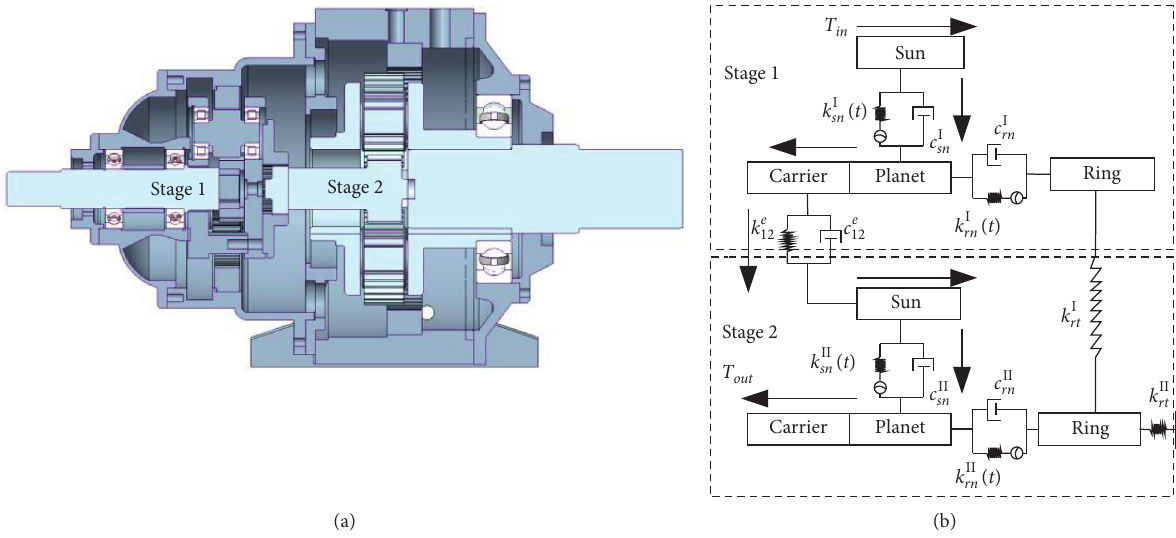
Figure 1: (a) The sectional drawing of the 2-stage planetary gearbox. (b) Schematic diagram of the 2-stage transmission structure.